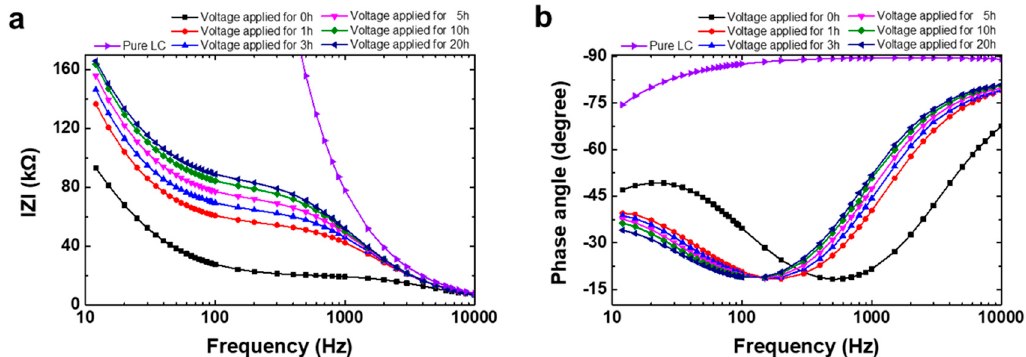
Figure 7. Measured impedance spectra of the ion-doped LC cell: ( a ) magnitude | Z | and ( b ) phase angle ϕ .